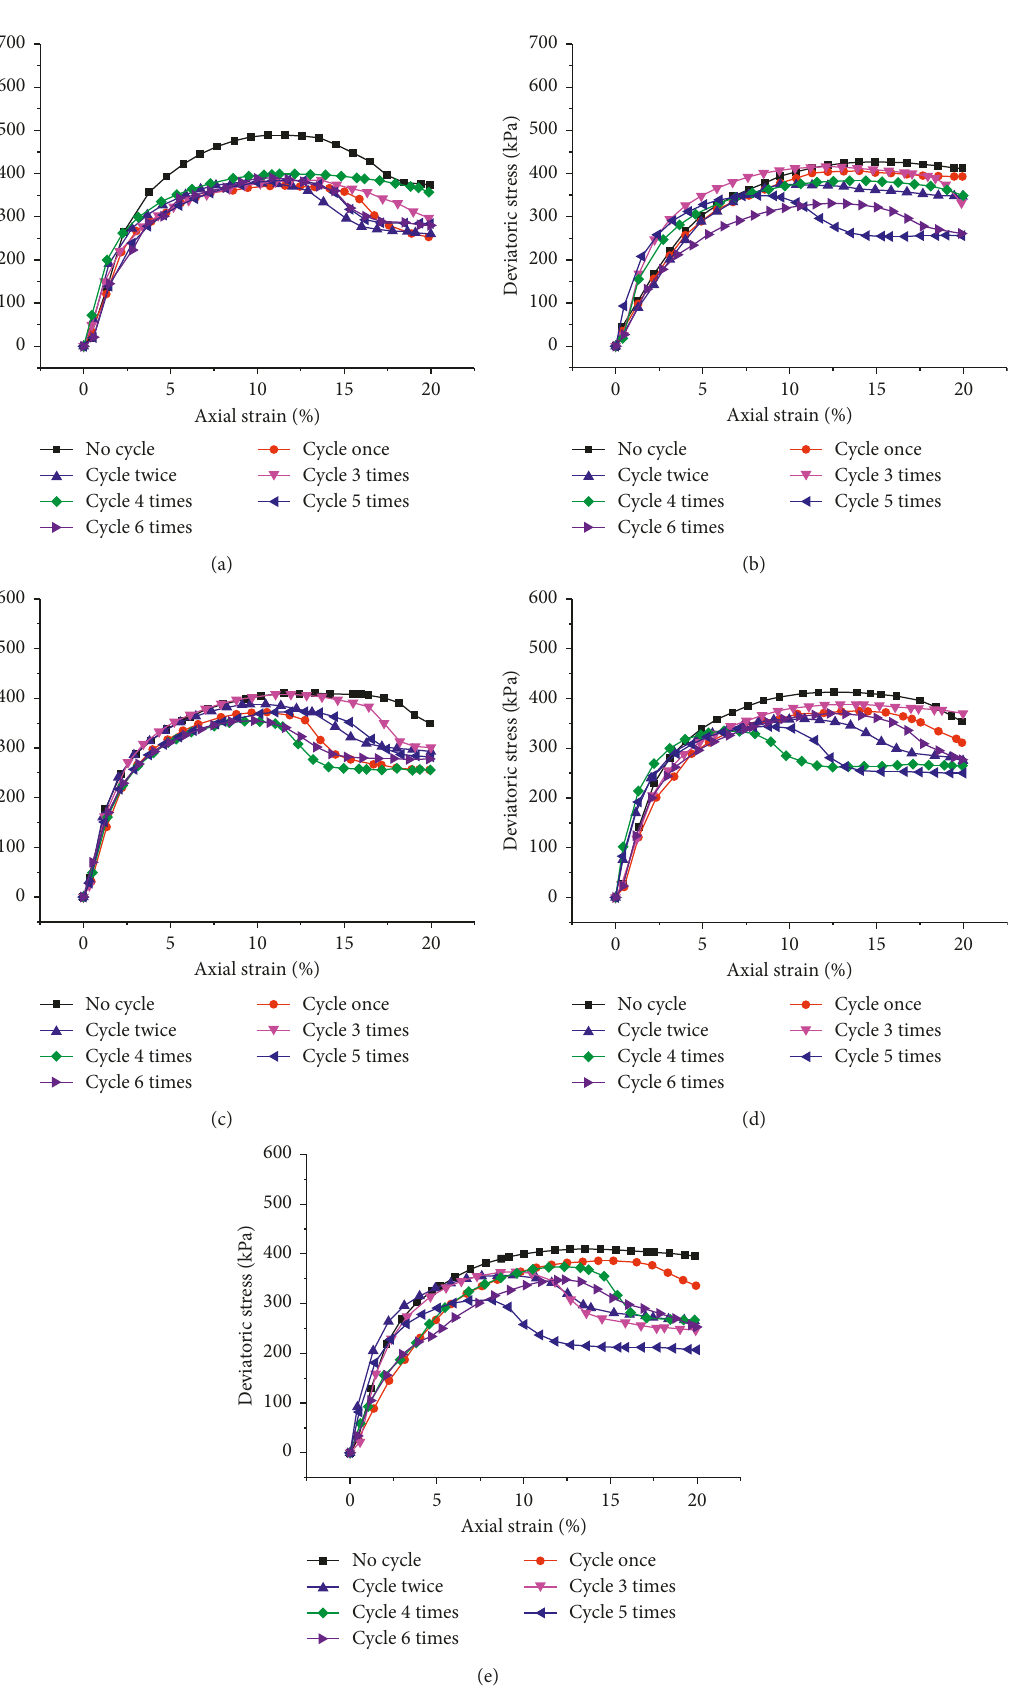
Figure 6: Stress-strain curves of samples with water content at natural dry density under different times of moisture absorption and desorption cycles. Water content: (a) 6.10%, (b) 10.40%, (c) 14.00%, (d) 18.20%, and (e)